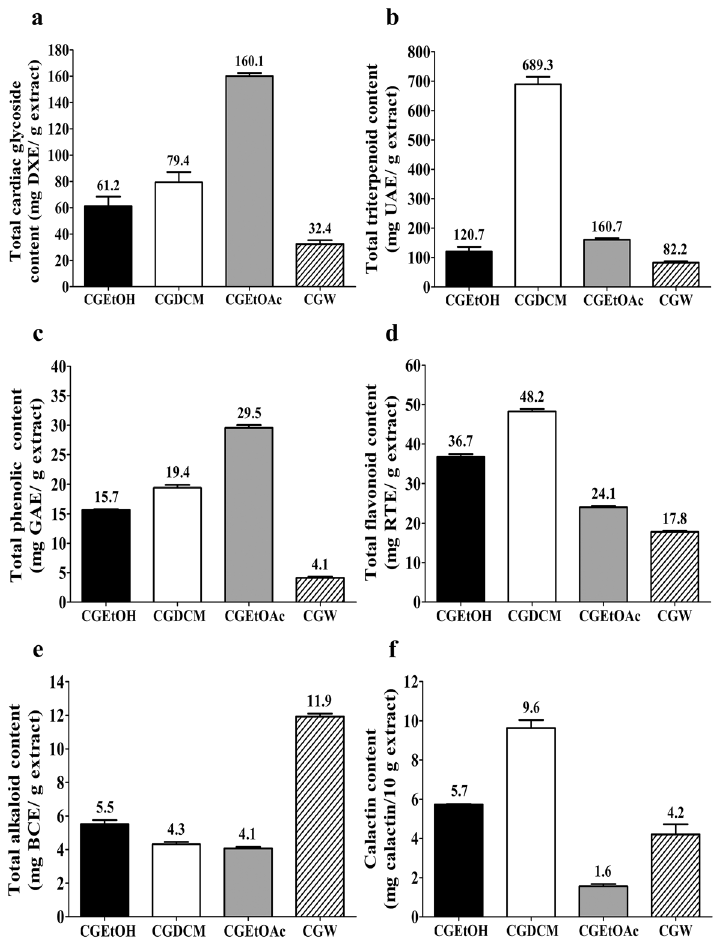
Figure 2. Phytochemical contents of C. gigiantea stem bark extracts, ( a ) total cardiac glycoside content (mg DXE/g extract), ( b ) total triterpenoid content (mg UAE/g extract), ( c ) total phenolic content (mg GAE/g extract), ( d ) total flavonoid content (mg RTE/g extract), ( e ) total alkaloid content (mg BCE/g extract) and ( d ) Calactin content (mg calactin/10 g extract), where DXE is digoxin equivalent, UAE is ursolic acid equivalent, GAE is gallic acid equivalent, RTE is rutin equivalent and BCE is berberine chloride equivalent. CGEtOH, CGDCM, CGEtOAc, and CGW are the total ethanolic extract, dichloromethane fraction, ethyl acetate fraction and water fraction of C. gigantea stem bark,